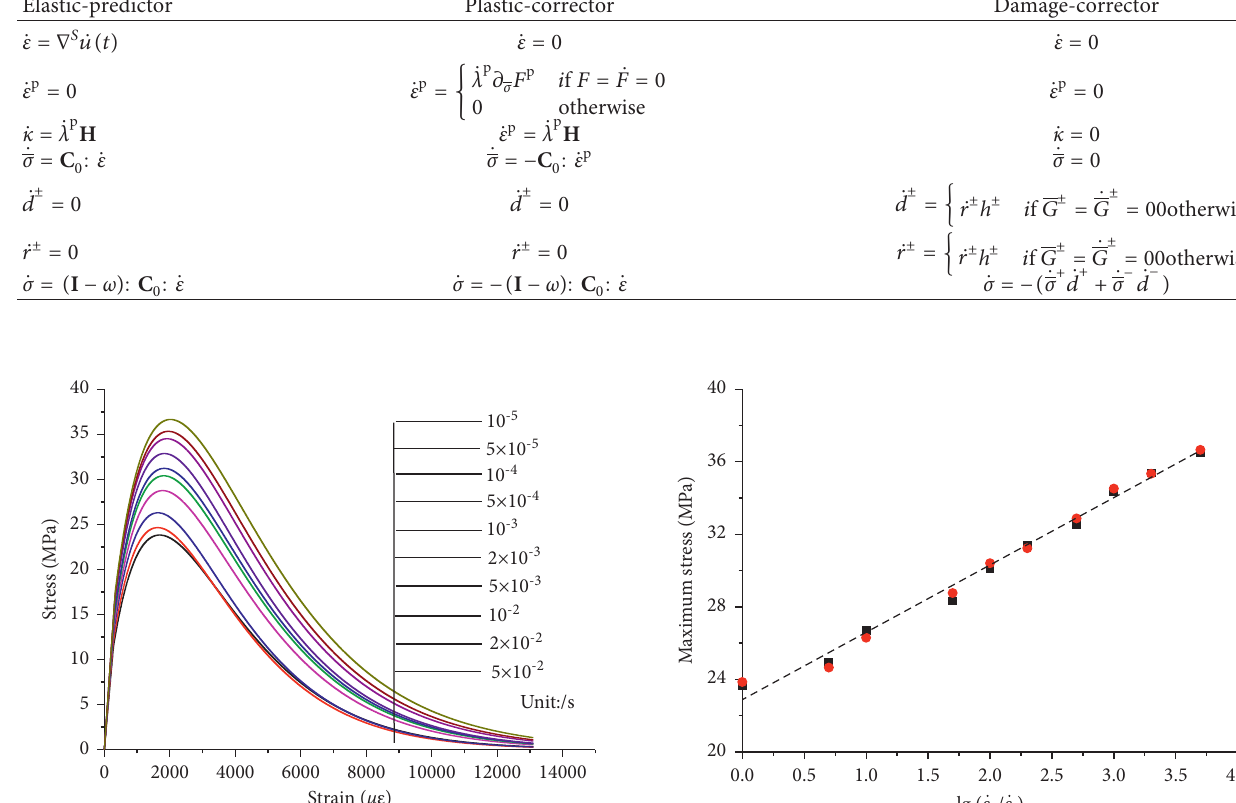
Figure 7: Simulation curves of light aggregate concrete under different strain rates following the stress-strain relationship.